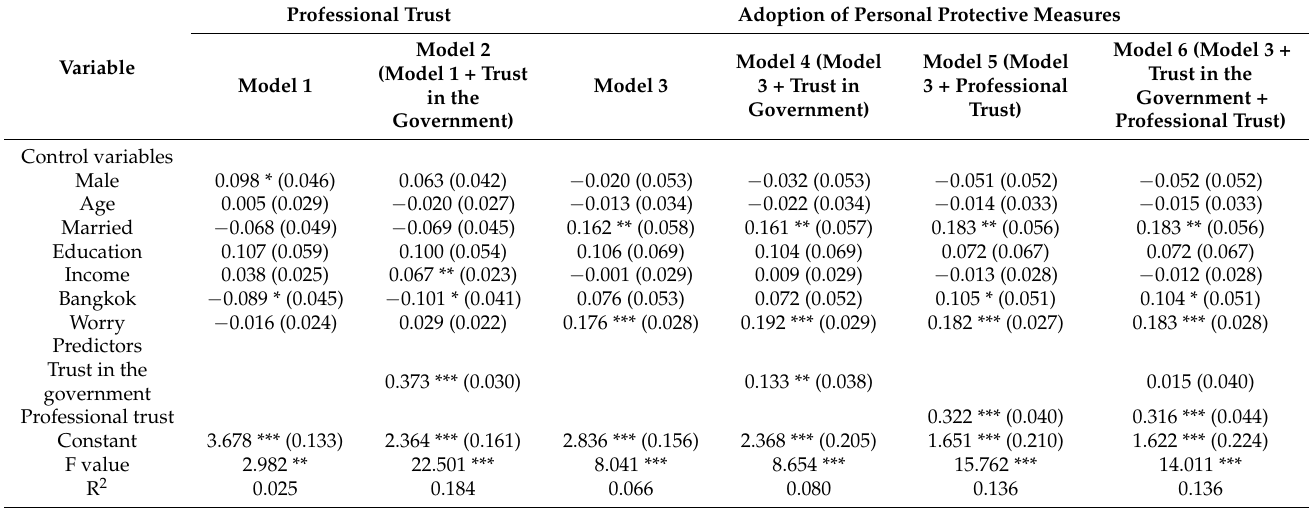
Table 5. Ordinary least squares (OLS) hierarchical regressions analyzing the relationship between public trust in government, professional trust, and the adoption of personal protective